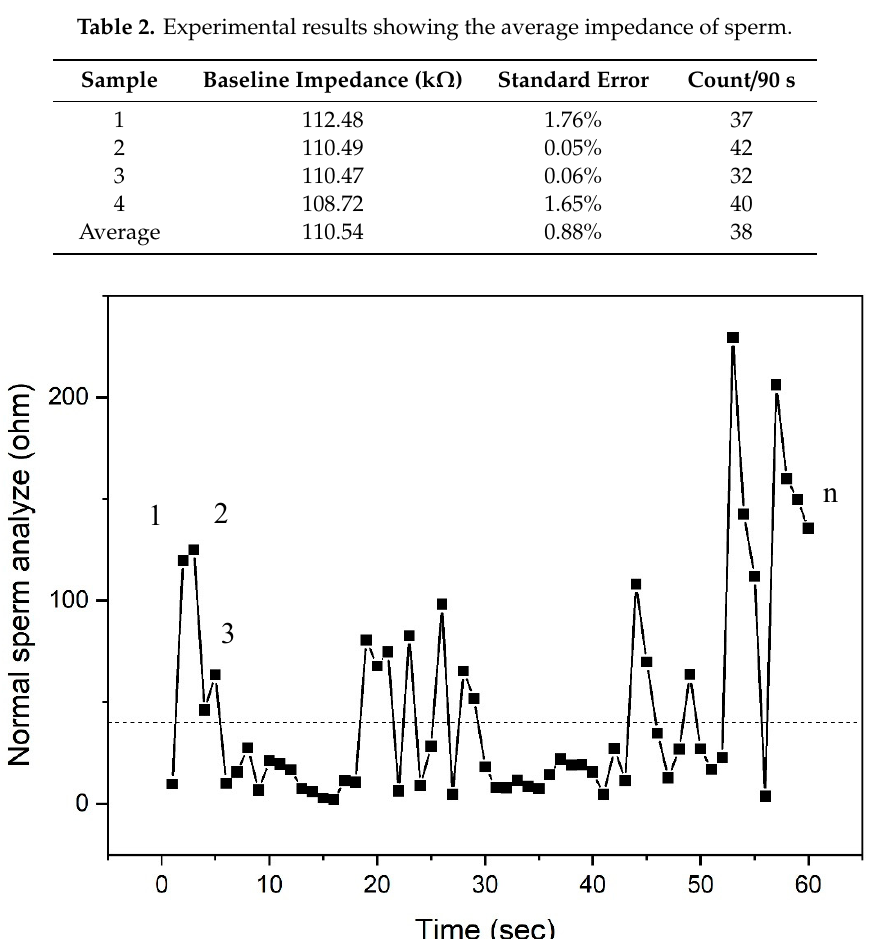
Figure 6. The sperm cell passing between the two electrodes.